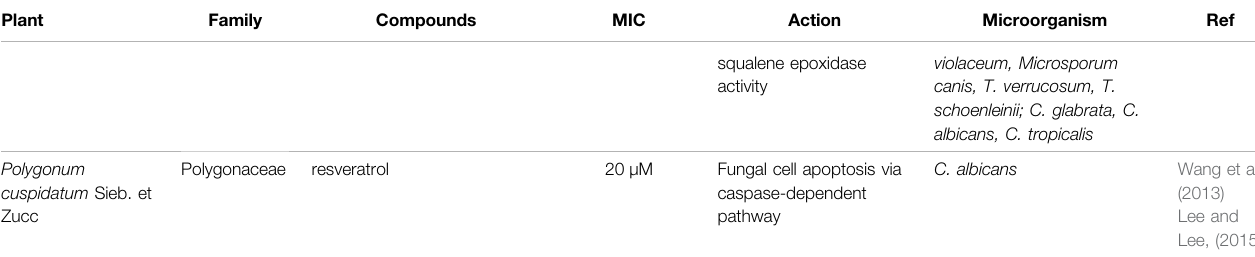
TABLE 1 | ( Continued ) Plants with antimicrobial